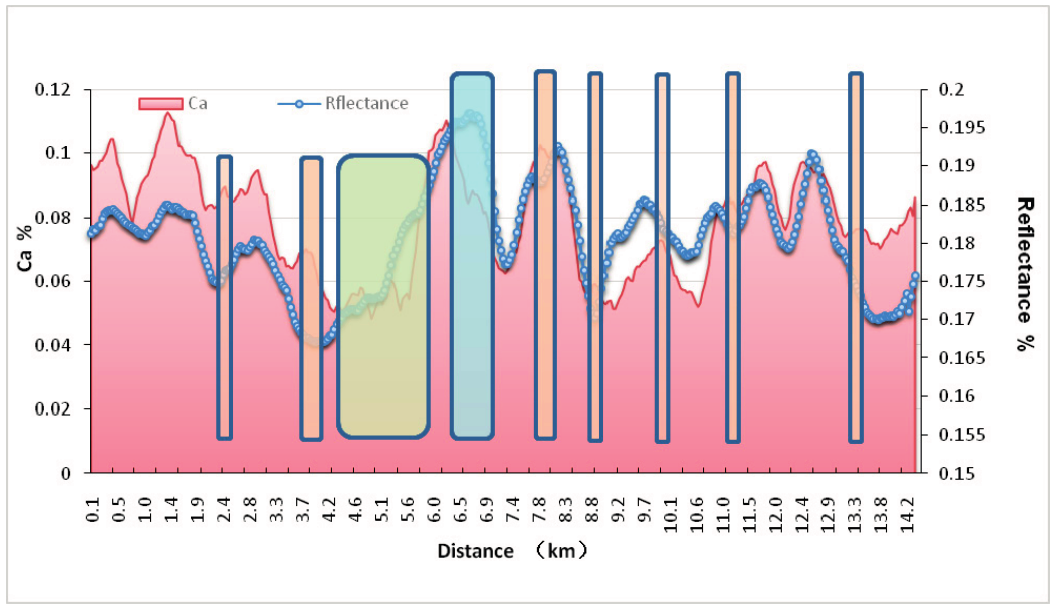
Figure 7. Correlation between Ca 2+ distribution and mean value of visible reflectance. The rectangles show the anti-correlated areas where Ca 2+ content has negative correlation with reflectance. The color of each rectangle shows the length of the anti-correlated area. Light green rectangle shows 4.2–5.6 km. Light blue rectangle shows 6.5–6.9 km. Light pink rectangle shows the anti-correlated